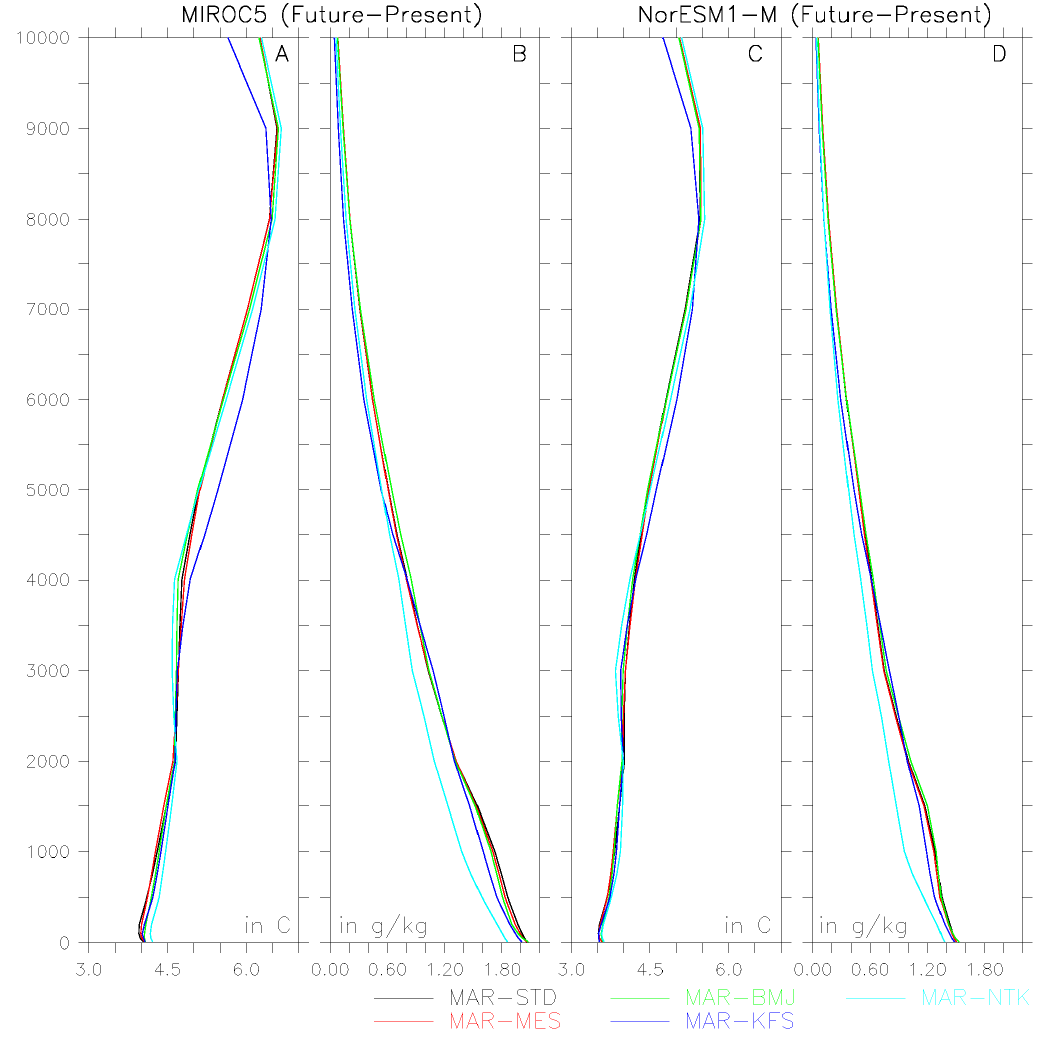
Figure 9. P rojected evolution (2070-2100) of the mean annual temperature profiles for MIROC5 ( A ) Figure 9. Projected evolution (2070–2100) of the mean annual temperature profiles for MIROC5 ( A ) and and NorESM1-M ( C ) in °C and of the specific humidity profile for MIROC5 ( B ) and NorESM1-M ( D ) NorESM1-M ( C ) in ◦ C and of the specific humidity profile for MIROC5 ( B ) and NorESM1-M ( D ) in in g/kg with regard to the present climate (1987–2017) and averaged over the study domain. g / kg with regard to the present climate (1987–2017) and averaged over the study